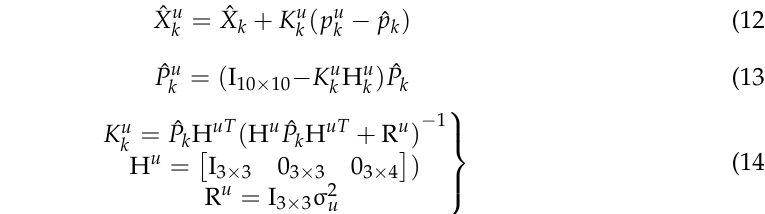
Figure 8. Block diagram of valid UWB observation detection having valid UWB position at left side and invalid UWB position at right side. (Black dot = IMU estimated position; green dot = UWB position in LOS; red dot = UWB position in NLOS.)